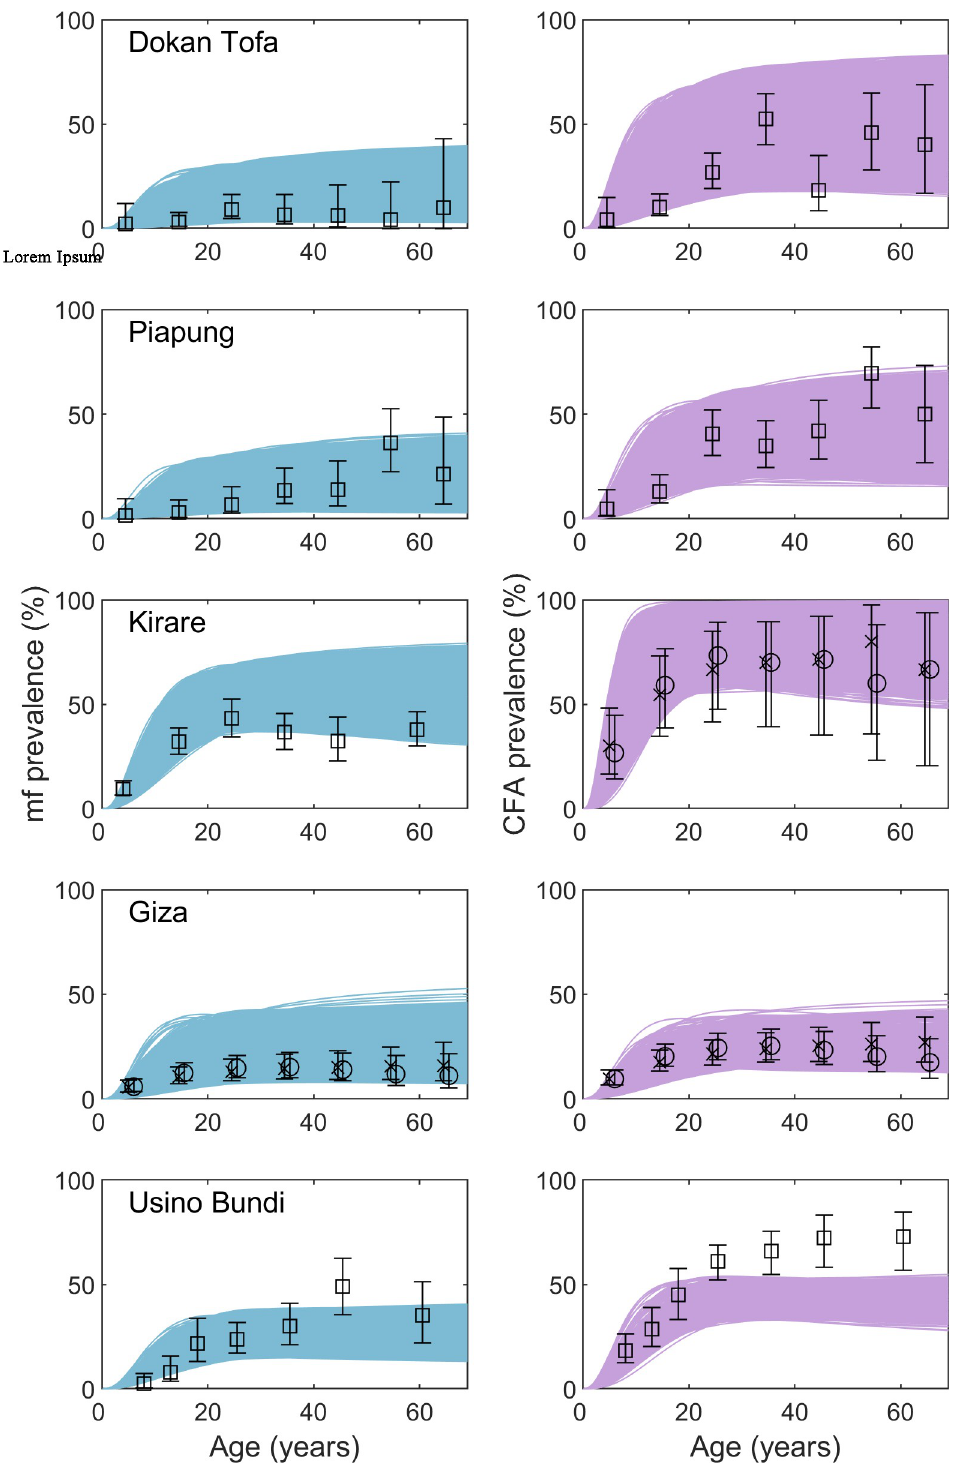
Fig 2. Model hindcasts of baseline mf and CFA infection prevalence compared to observed survey data. Each row of plots give the mf (left, blue curves) and CFA (right, purple curves) age prevalence for the given site at baseline. The curves represent the model-predicted infection by age compared to the observed (squares) or derived (plateau as crosses and convex as circles offset to visualize differences) age infection profiles. For all sites except CFA in Usino Bundi, the ensemble of curves passed through all of the data points indicating an accurate estimate of the baseline prevalence. Monte-Carlo p-values for assessing goodness of fit were > 0.9 in each case. https://doi.org/10.1371/journal.pcbi.1007506.g002 PLOS Computational Biology | https://doi.org/10.1371/journal.pcbi.1007506 July 21,